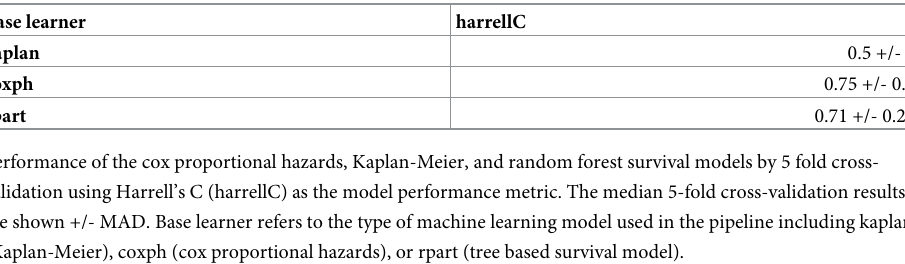
Table 4. Comparison of survival model performance by 5 fold cross-validation on the training data.